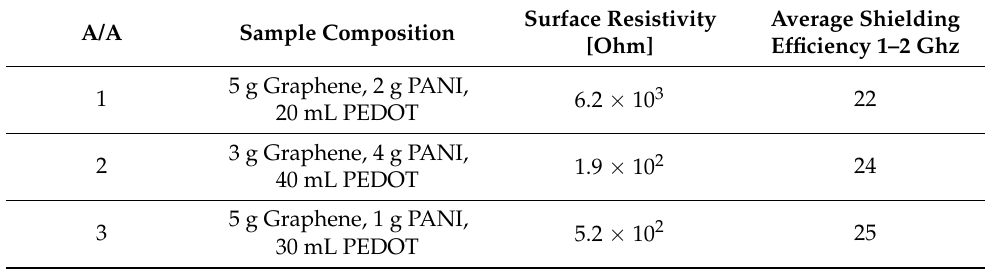
Table 1. Conductivity and average shielding efficiency for PANI/graphene/PEDOT:PSS coatings of various compositions.